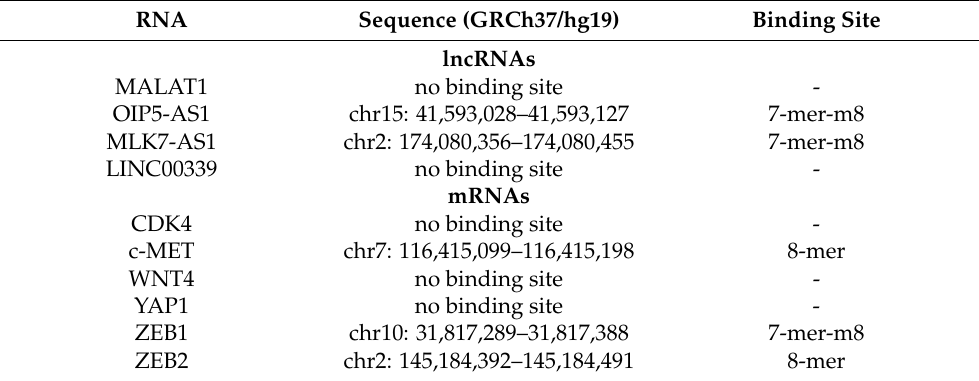
Table 3. Data on the possibility of miR-203 binding to the selected lncRNAs and mRNAs.